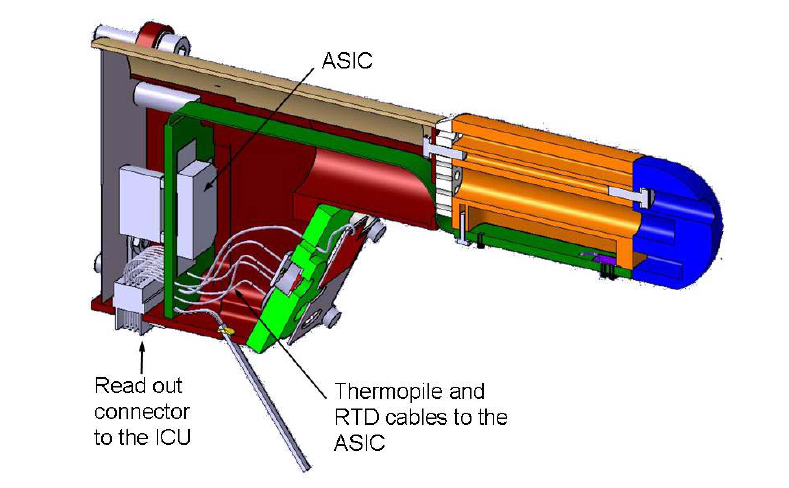
Figure 5. A 3D electro-mechanical model of REMS GTS and Boom ASIC.